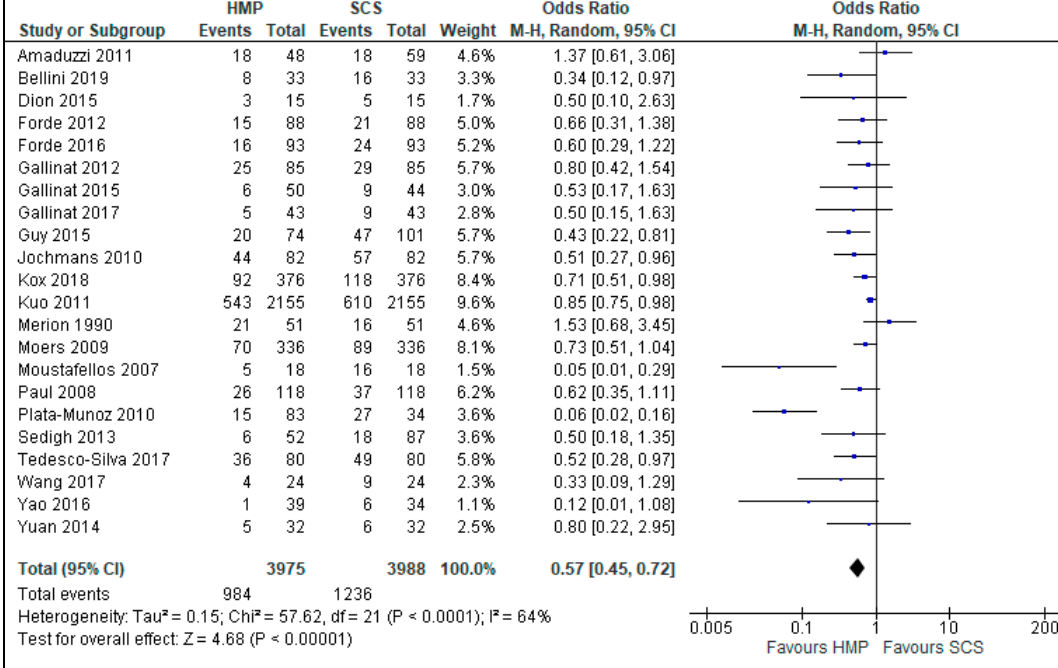
Figure 4. DGF duration in kidneys preserved by HMP and SCS. DGF duration was measured in days. In papers marked with “ * ”, mean and standard deviation were calculated using the method described by Wan 2014 [3]. 3.6. Acute Rejection There was no significant difference in the prevalence of acute rejection in kidneys preserved by HMP or SCS (OR: 0.91 95% CI 0.66 to 1.27, p > 0.05). Five studies [12,15,19,23,25] were used for the meta-analysis of a total of 1193 patients (Figure 5). Figure 5. Acute rejection in Kidneys preserved via HMP and SC.